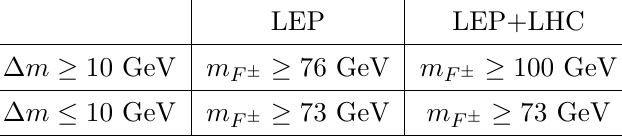
(cid:20) 100 GeV, F (cid:6)